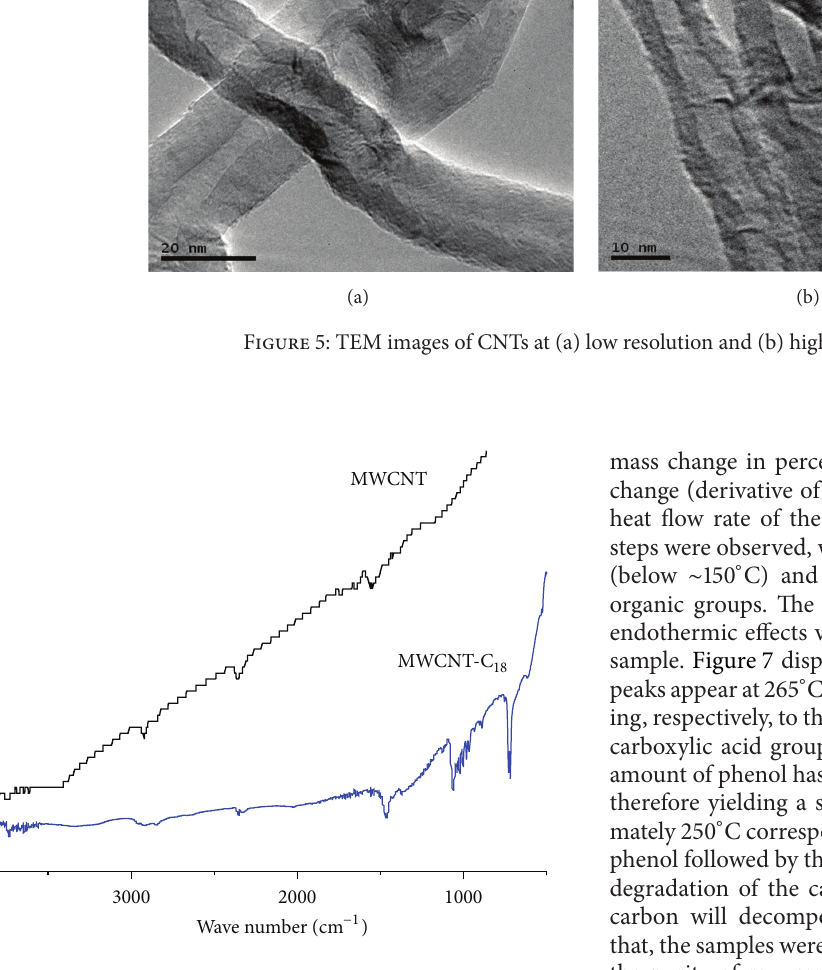
Figure 6: FTIR spectra of MWCNT and 1-octadecanol (C 18 ) mod- ified